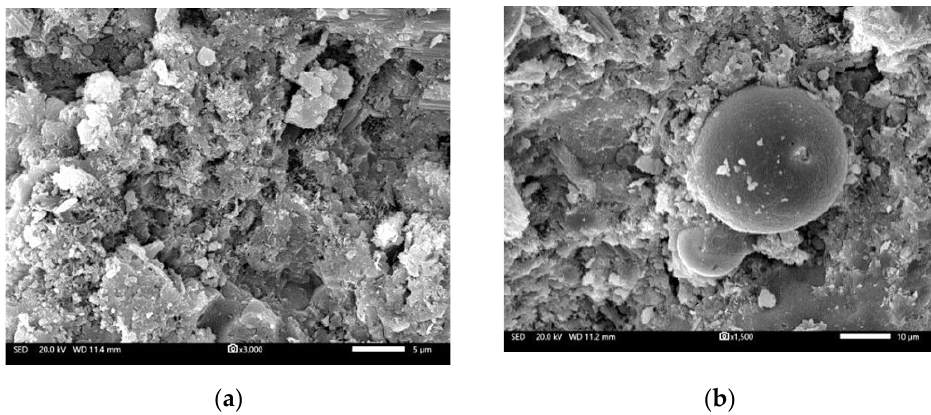
Figure 12. SEM pictures of FA25-P under the FC2 condition, ( a ) Microstructure and ( b ) FA particles in paste.